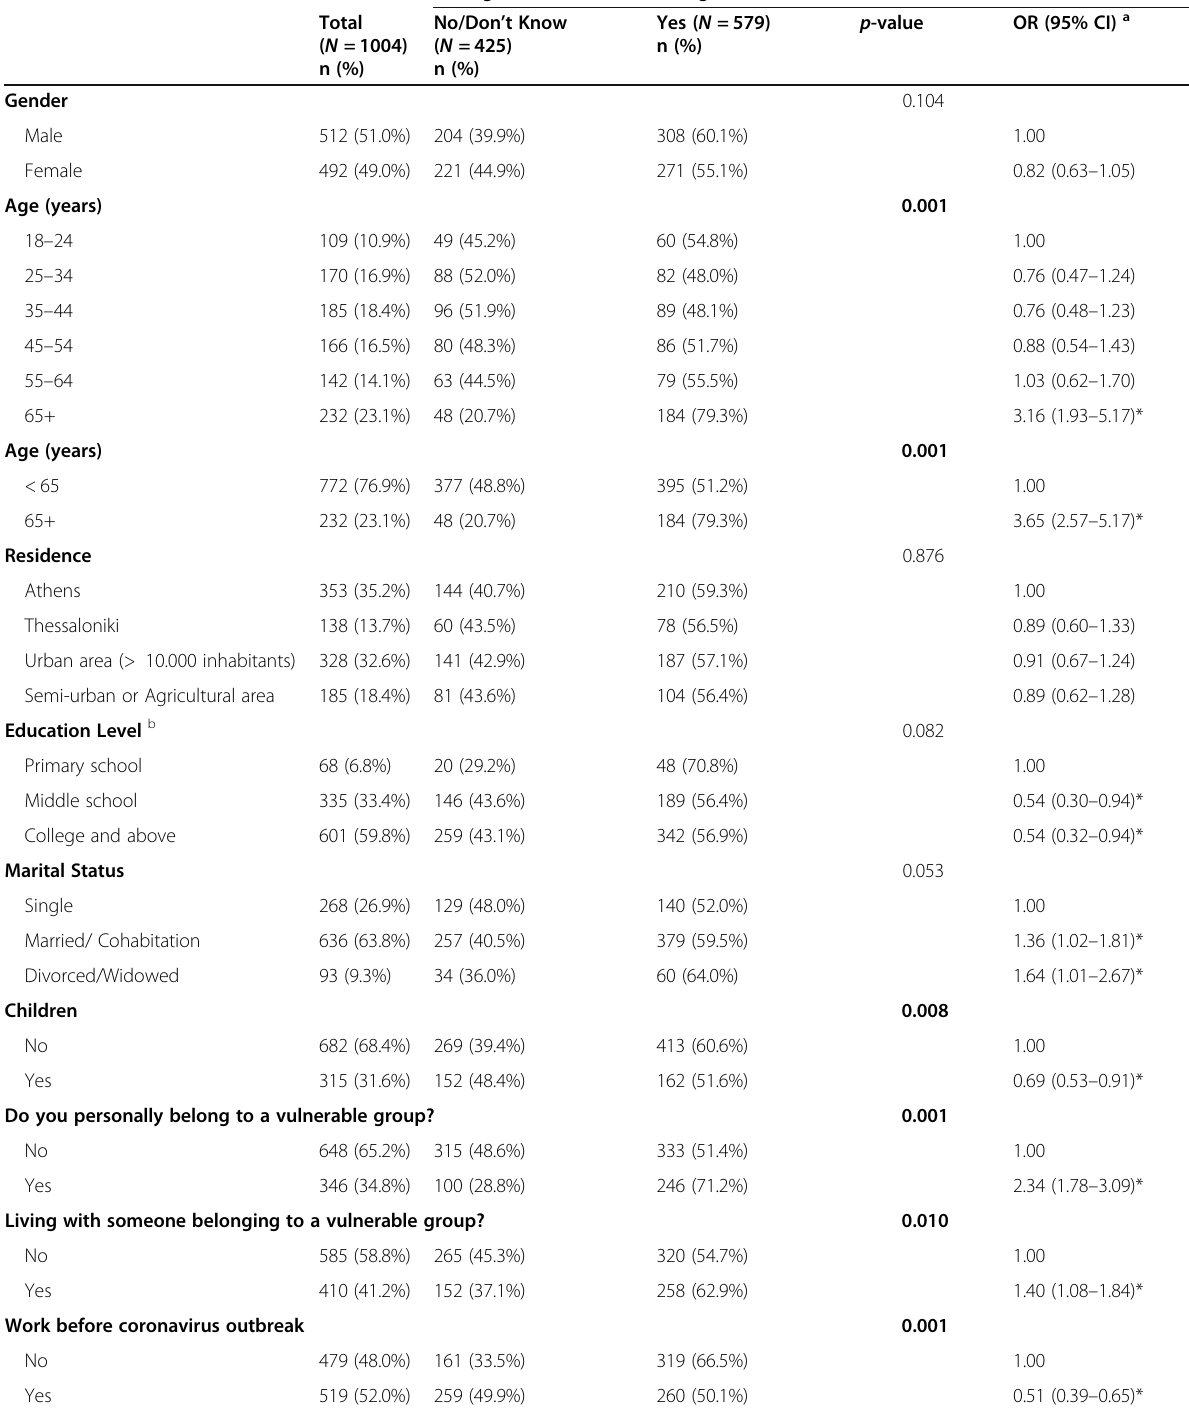
Table 1 Associations between demographic characteristics and willingness of respondents to get vaccinated for COVID-19 in